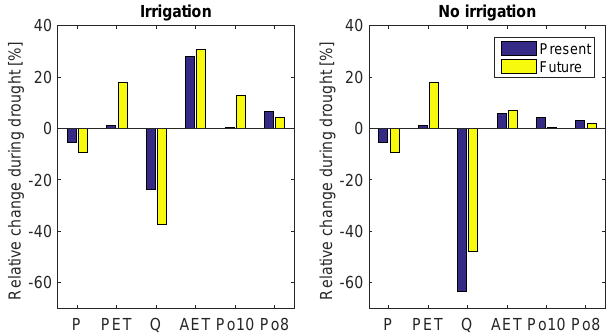
Figure 9. Average hydrological impacts of present and future (2040–2050) droughts. From left to right: relative changes in mean annual precipitation, ET 0 , discharge, actual evapotranspiration, and water-table depth at the observation wells Po8 and Po10. For sim- plicity, droughts are here defined as years with SPEI and SPI values of lower than one. Future conditions are based on the average of the outputs of the four regional climate models (Table